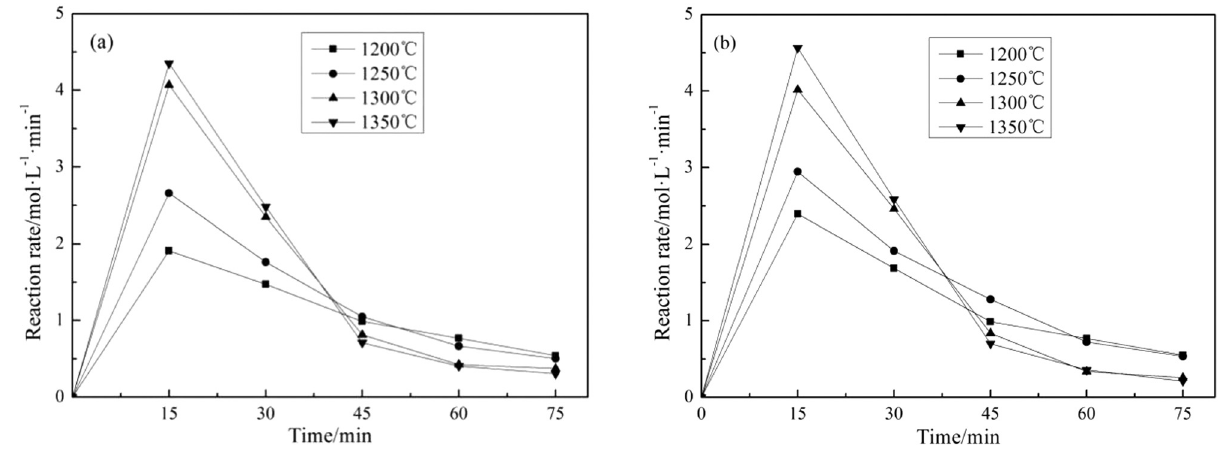
Figure 6: Relationship between the reaction rate containing SiO 2 ( a ) and fl y ash ( b ) at di ff erent reaction time and